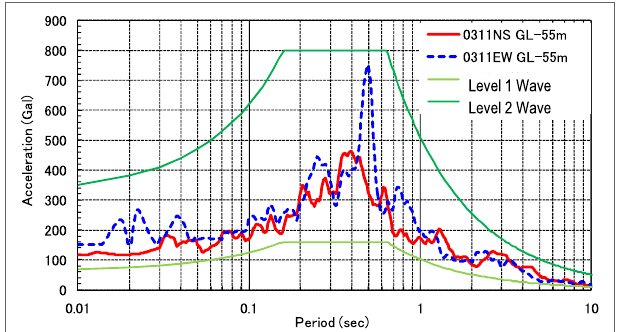
FigUre 2 | Comparison of acceleration spectra between the 3/11 main shock and the Japanese design earthquakes of Level 1 and Level